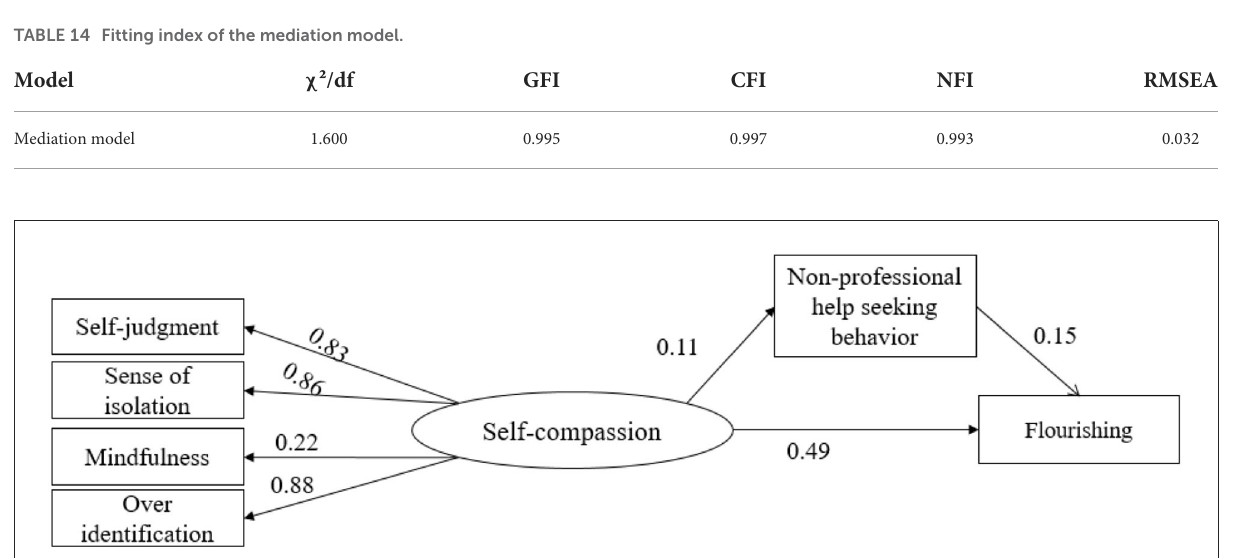
FIGURE5 Mediating model of non-professional help-seeking behavior between self-compassion and flourishing.